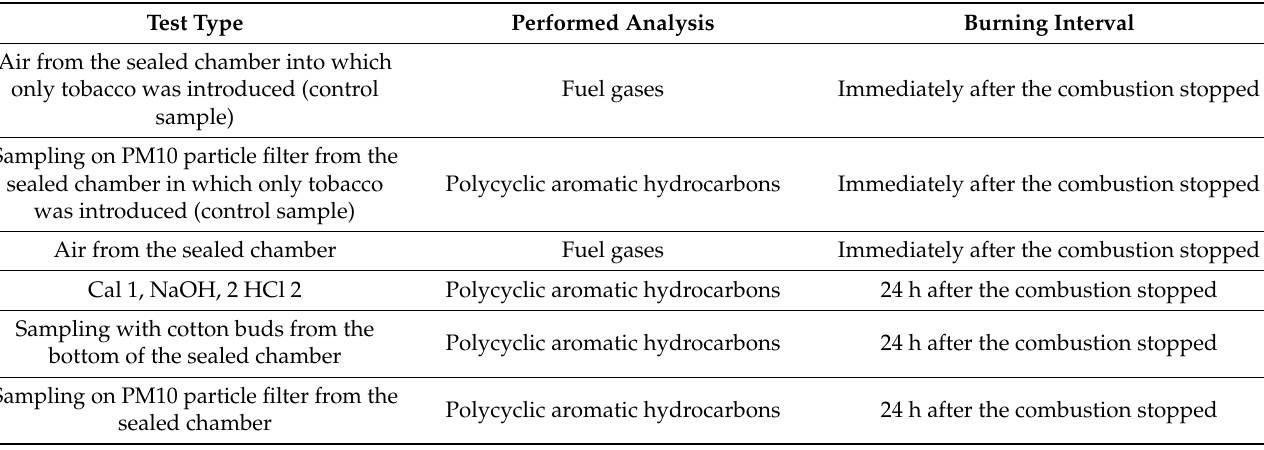
Table 2. Experiments performed for evaluation of the degree of adsorption of tobacco smell. Test